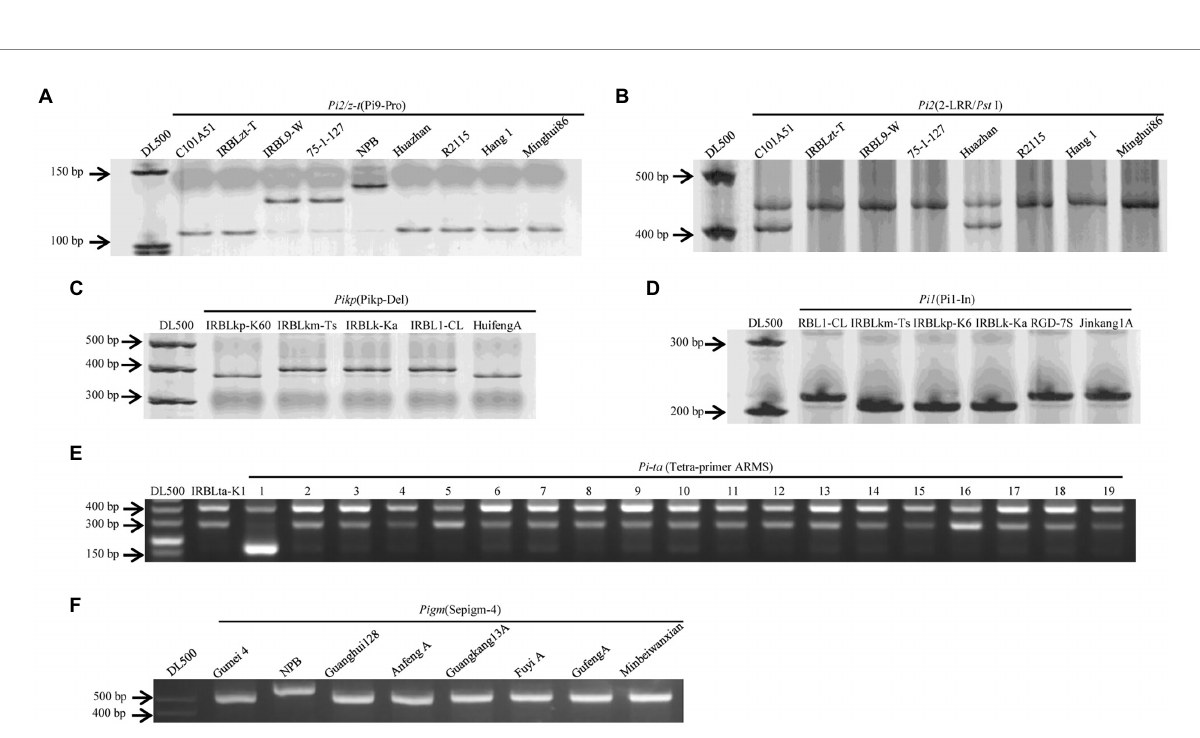
FIGURE 3 Electrophoretic gel of nine genes containing in the 117 cultivars. E , Number in Pi-ta : Positive control, IRBLta-K1; 1, NPB: Nipponbare; 2, Wanlixian; 3, Shuhui527; 4, Huazhan; 5, Minhui 3301; 6, Jiayu293; 7, RGD-7S; 8, Nanhui 511; 9, Shuhui 316; 10, Shen 08S; 11, Zhefu 802; 12, Duoxi1; 13,Ezao11; 14, Minghui82; 15, Shuhui 881; 16, Zhongxiang 1; 17, Chenghui 3203; 18, Lehui 188; 19, R2155. The other gene-containing cultivars in A – D and F are showen in